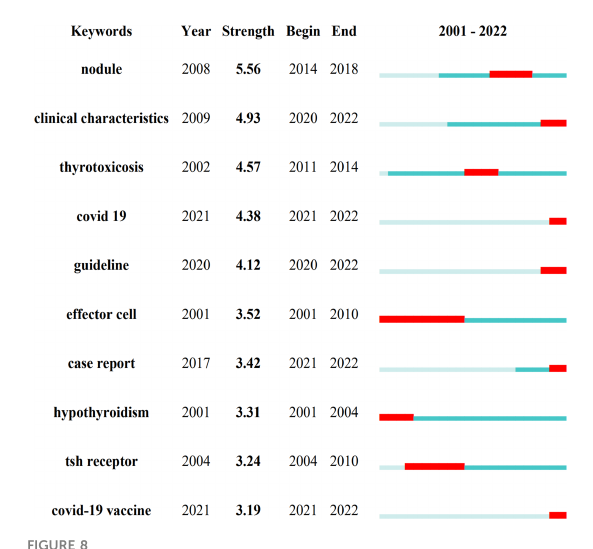
FIGURE 8 Keywords with the strongest burst strength. The blue line represents the period from 2001 to 2022 and the red line represents the burst's maintenance